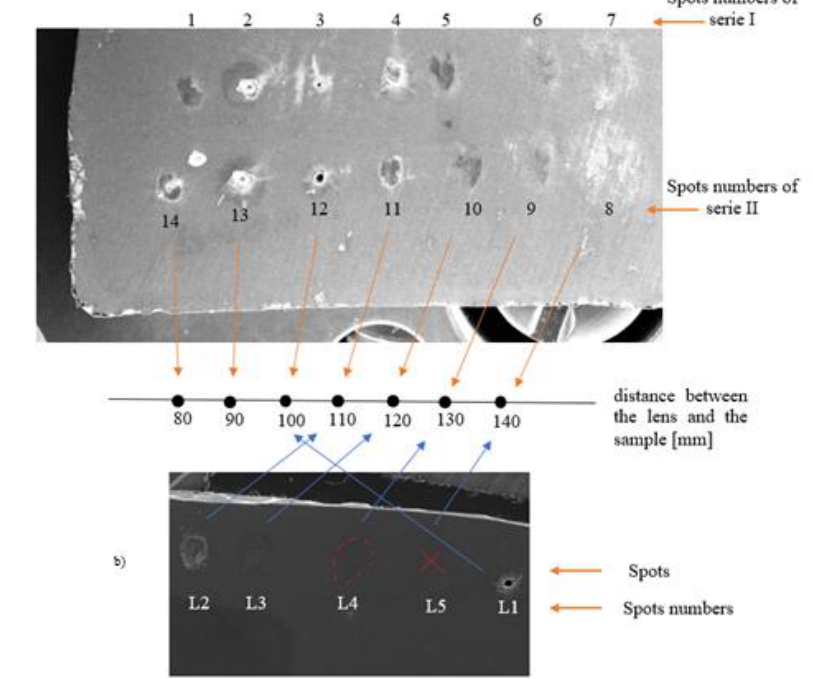
Figure 2. Laser beam spots ( a ) on the bulk sample of NC5MI; ( b ) on the layer of NC5MI deposited on Si.